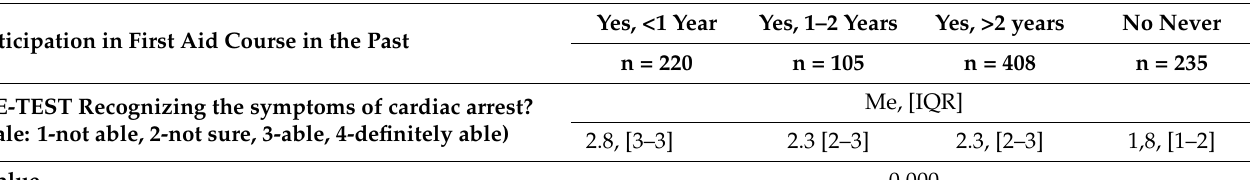
Table 1. Self-confidence scores for the ability to recognize cardiac arrest symptoms depending on previous